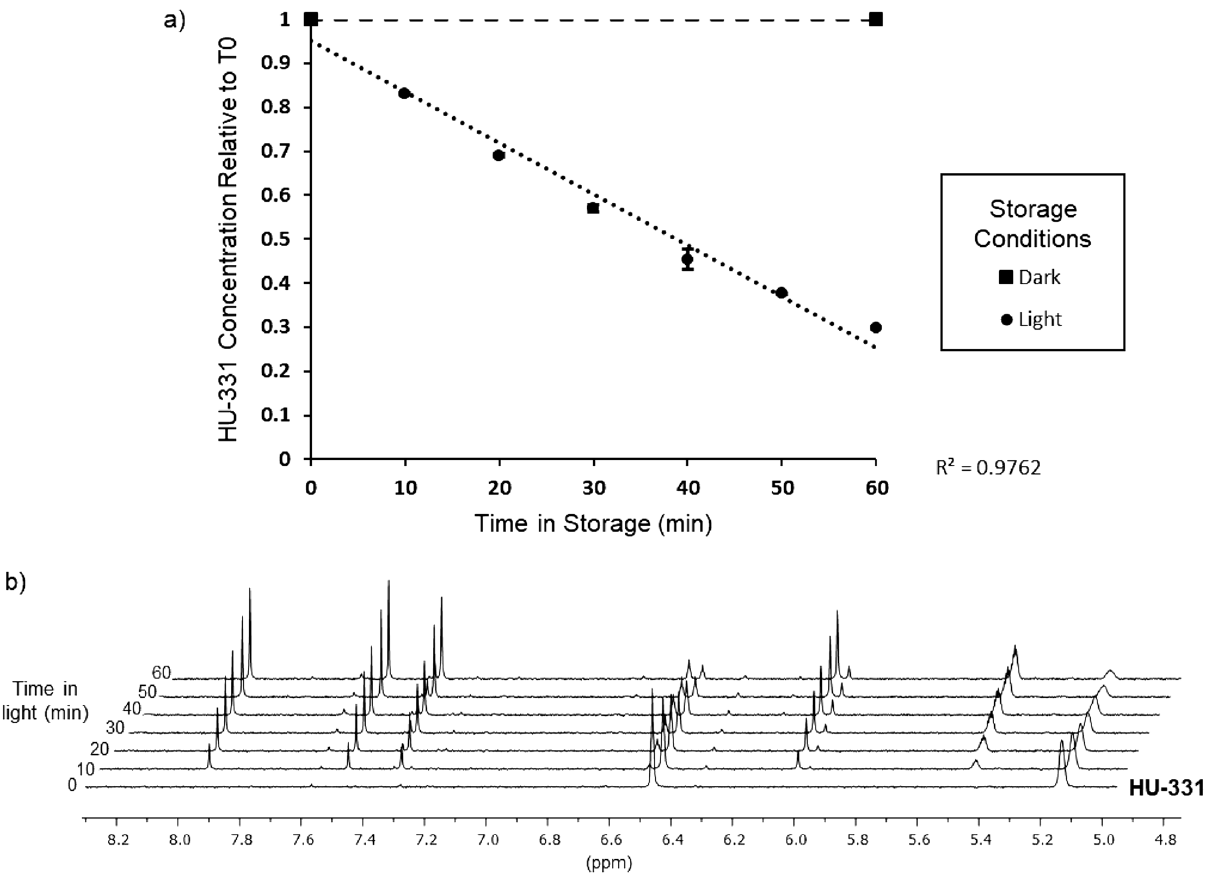
Figure 2. Effect of visible light on HU-331 concentrations. ( a ) Changes in concentration of HU-331 (6 mM in DMSO- d 6 ) stored in the dark (squares) or exposed to 6500 K fluorescence (circles) for up to 60 min. HU-331 concentration was measured by 1 H-NMR. ( b ) 1 H NMR of HU-331 samples degraded by white light over